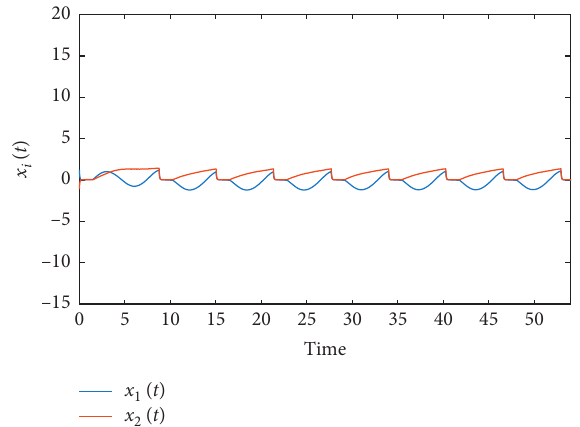
( i � 1 , 2 ) of system (112) under the i